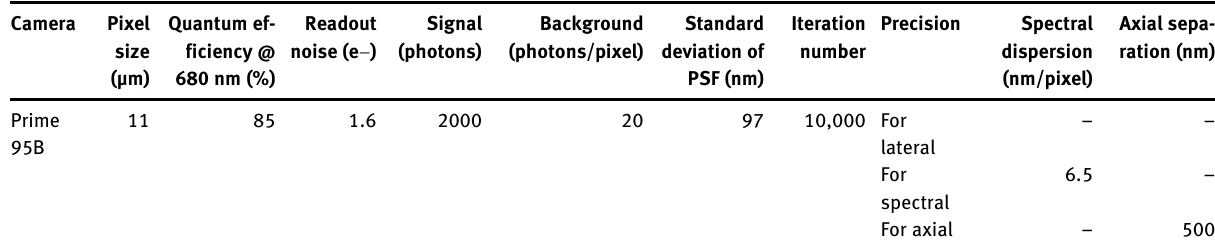
Table  : List of parameters used in simulations. Camera